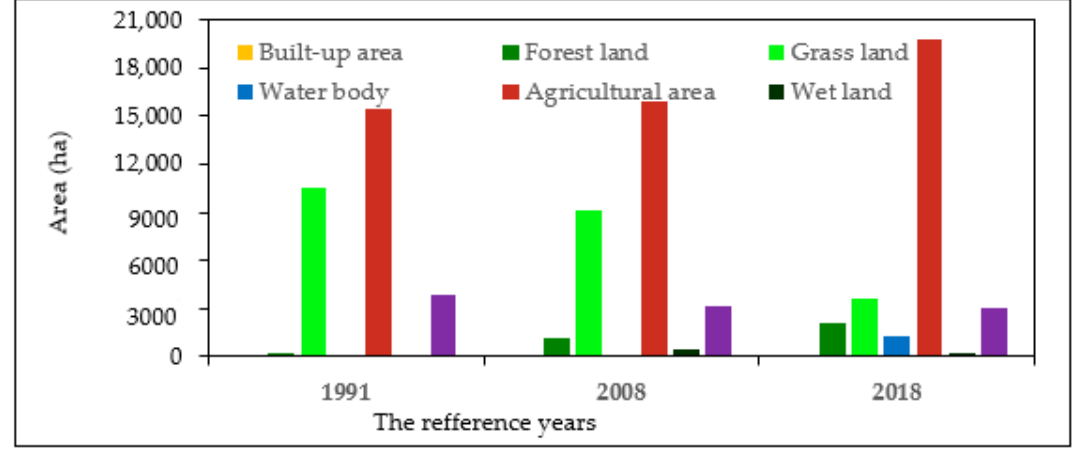
Figure 5. The magnitude (in ha) of land use/cover of the area.